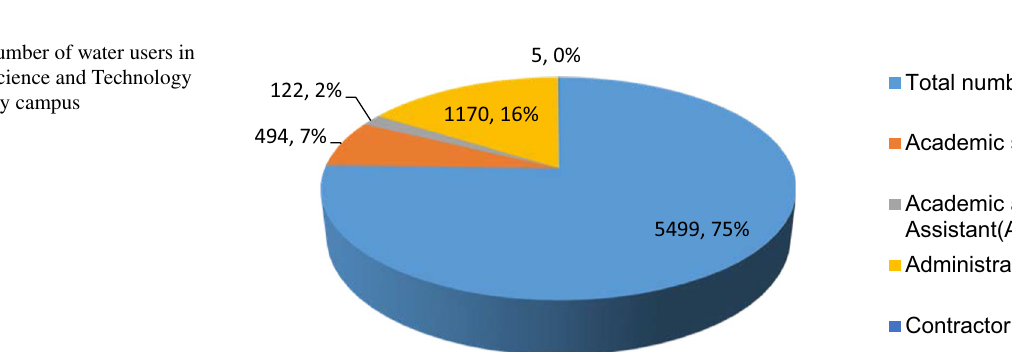
Fig. 4 Daily frequency of water consumption and the percentage pro- portion value inside the ASTU campus before the corona virus pan-